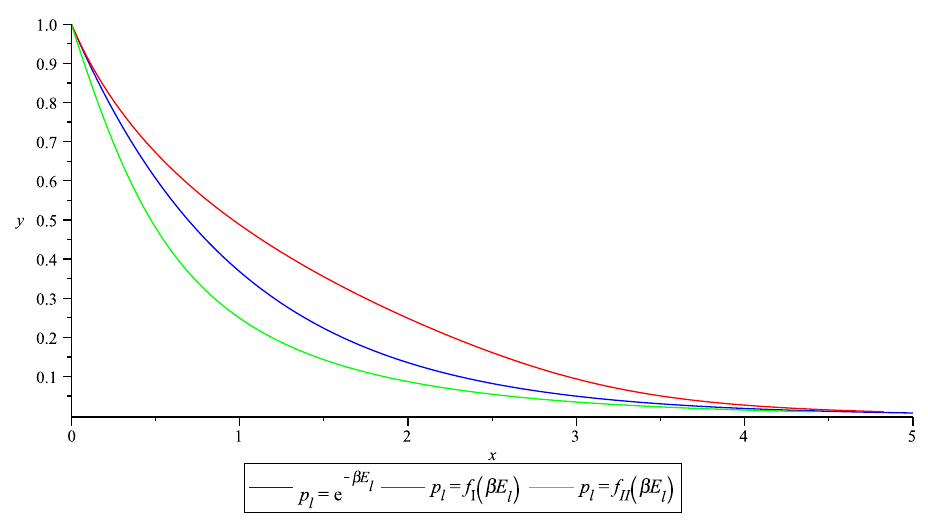
Figure 4. Comparison of the three probabilities. The blue line corresponds to the standard one p l = e − β E l , red line to p l = g I ( β E l ) Equation (1), and green line p l = g II ( β E l ) , Equation (2).